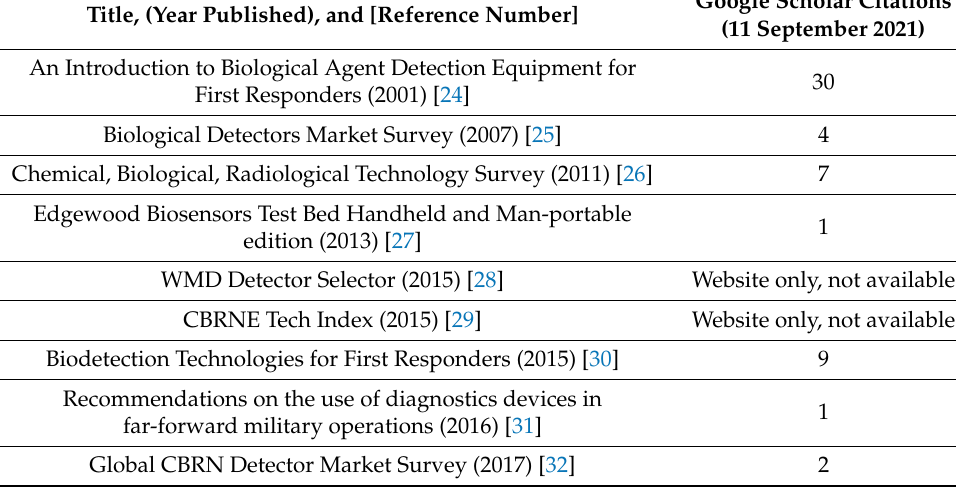
Table 1. List of field and first responder biodetection marketing references including print and electronic formats available online. Citations counted from 11 September